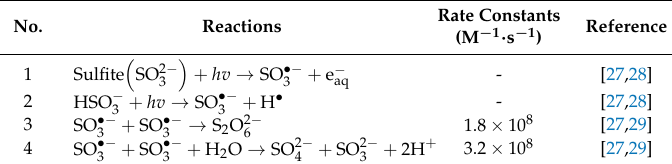
Table 2. Summary of related reaction equations during the